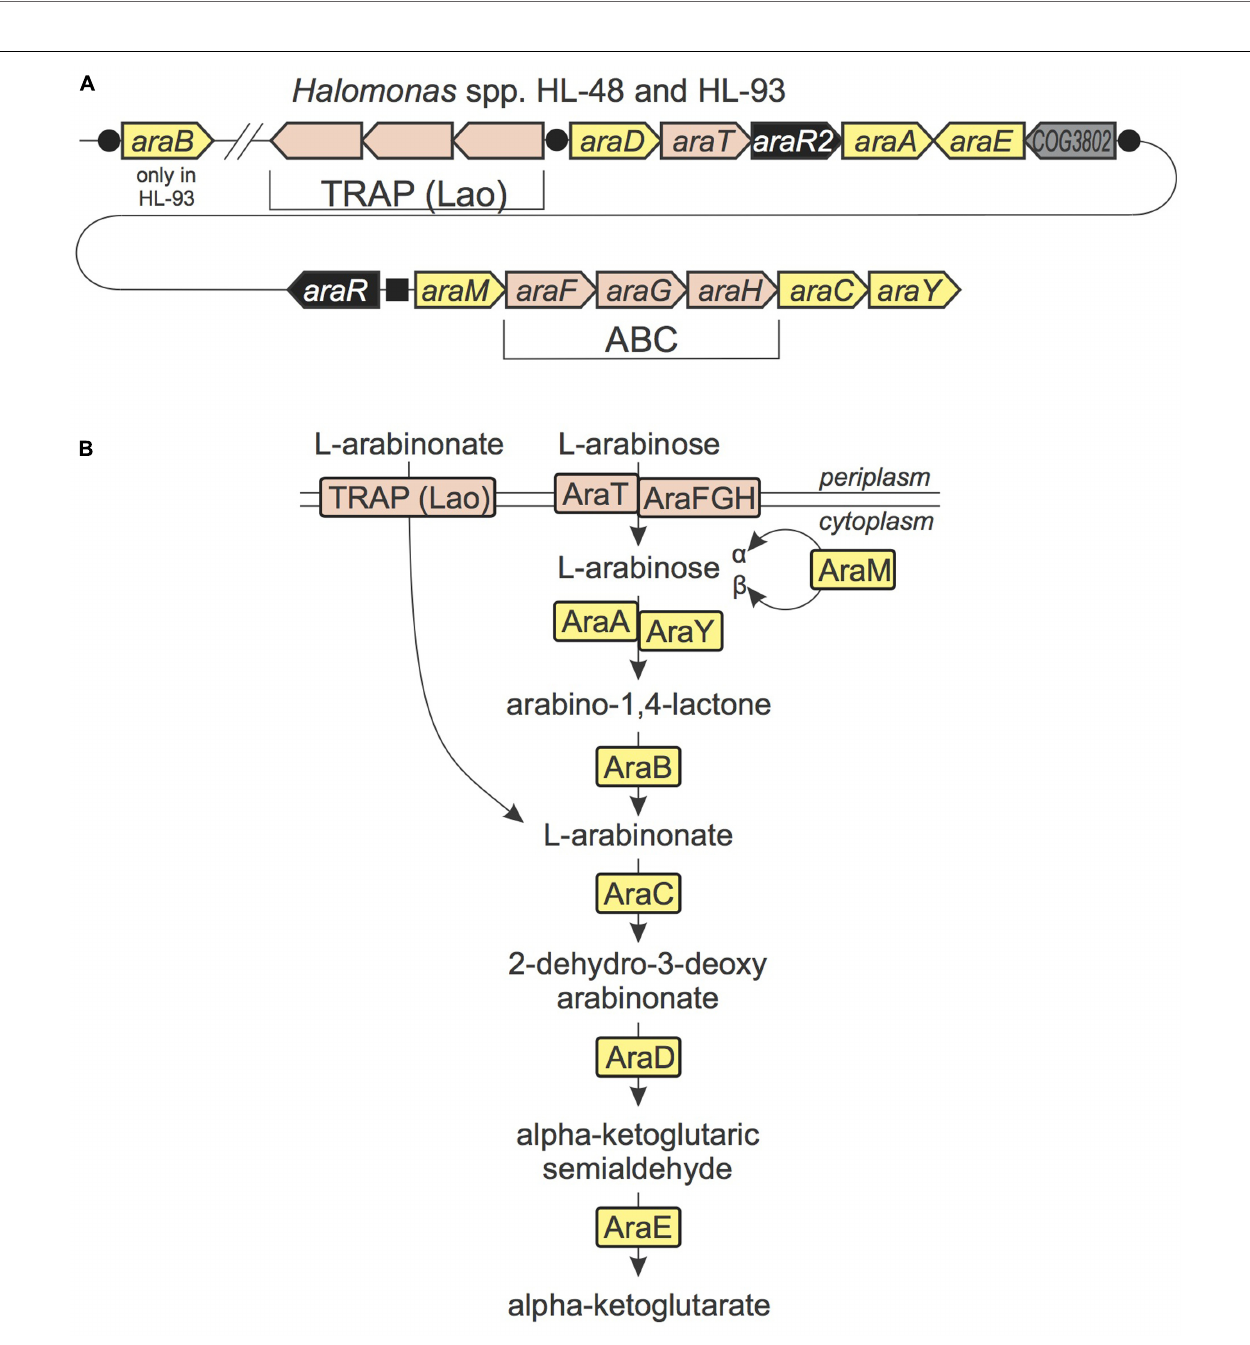
pathway, whereas in HL-49 L -fuconate dehydratase FucD is missing and L -fucose dehydrogenase is substituted with a novel non-orthologous dehydrogenase (named FucO II ). The four UCC genomes have different transporters encoded in the fuc